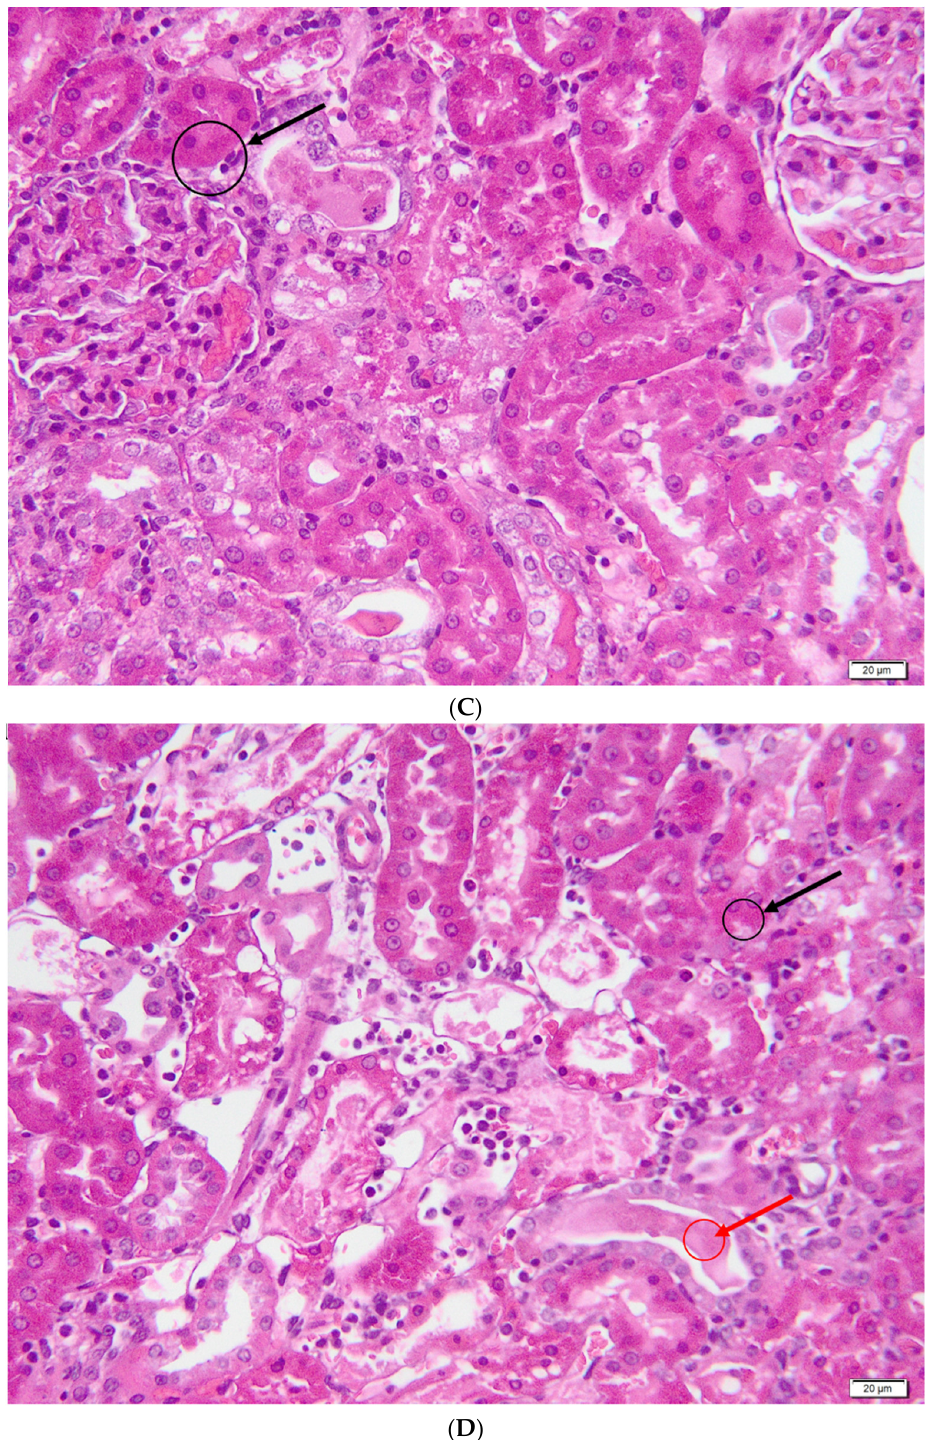
Figure 7. Curcumin group — histological aspects. ( A ) — Acute renal tubular necrosis (black arrow) and hypercellularity at the glomerular level (red arrow); ( B ) — Bowmann capsule thickening (blue arrow) and hydropic, multifocal, moderate degeneration (black arrow); ( C ) — Tubulo-interstitial nephritis, multifocal, discrete (arrow); ( D ) — Intracellular (black arrow) and extracellular (red arrow) hyalinosis associated with an area of renal tubular epithelial necrosis.